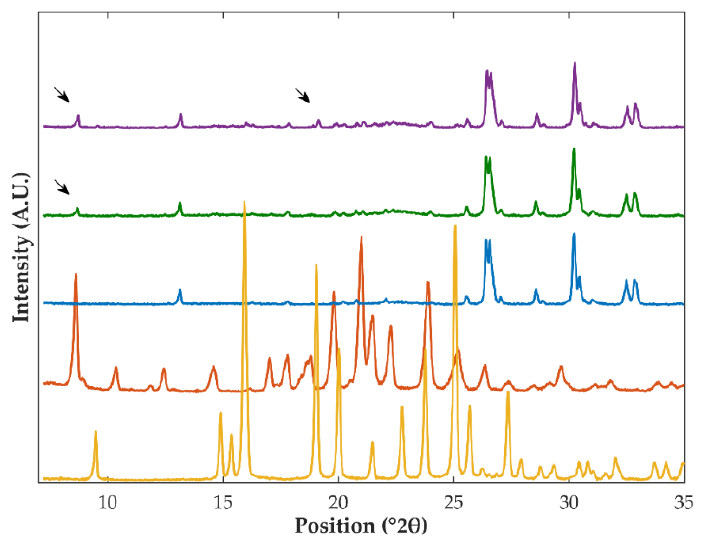
Figure 4. Diffractograms of crystalline saccharin (yellow), crystalline olanzapine (orange), and the physical mixtures obtained from the placebo formulation P (blue) and blends containing crystalline olanzapine (green, formulation I) or olanzapine and saccharin (purple, formulation II). Arrows highlight the peaks present in diffractograms, which could be related to either crystalline olanzapine or saccharin.